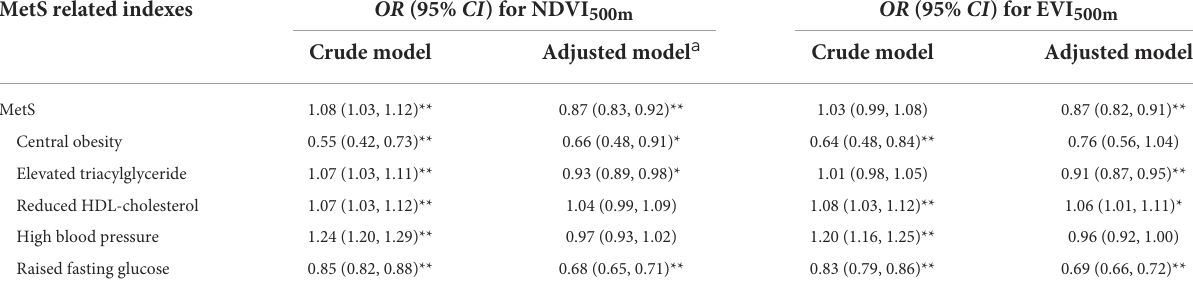
TABLE 2 Associations of each IQR increase residential greenness exposure in NDVI 500m and EVI 500m with the MetS risk. MetS related